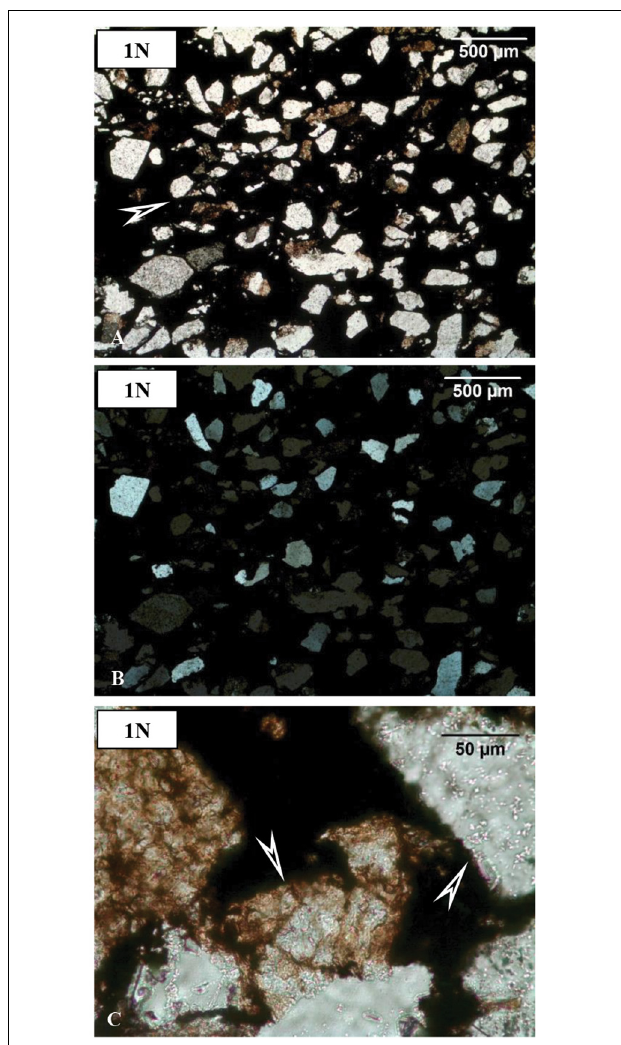
FIGURE 5 | Microtextural features of sample COR-10 by OM. (A) Debris-like grains (mainly quartz, altered feldspar, and fragments of jasper) in opaque matrix (arrow, 1N, and transmitted light). (B) Crossed N of (A) , showing polysynthetic twin microtextures of plagioclase (arrow). (C) Brown mineralized microbial biosignatures along and inside debris-like grains (arrows, transmitted light, and 1N).